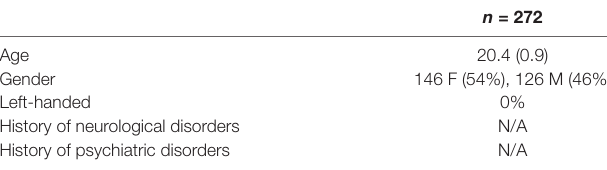
TABLE 1 | Demographic information for